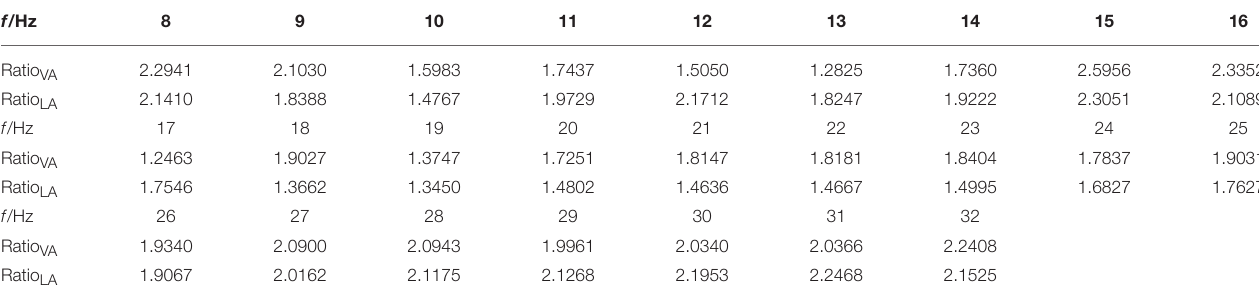
TABLE 2 | Different excitation frequency f , lateral amplitude (LA) ratio and vertical amplitude (VA) ratio ( I = 0 A’s amplitude, I = 2 A’s